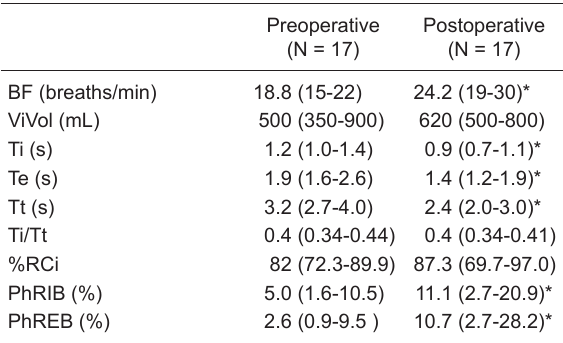
Table 3. Respiratory inductive plethysmographic variables in the preoperative and postoperative periods during spontaneous